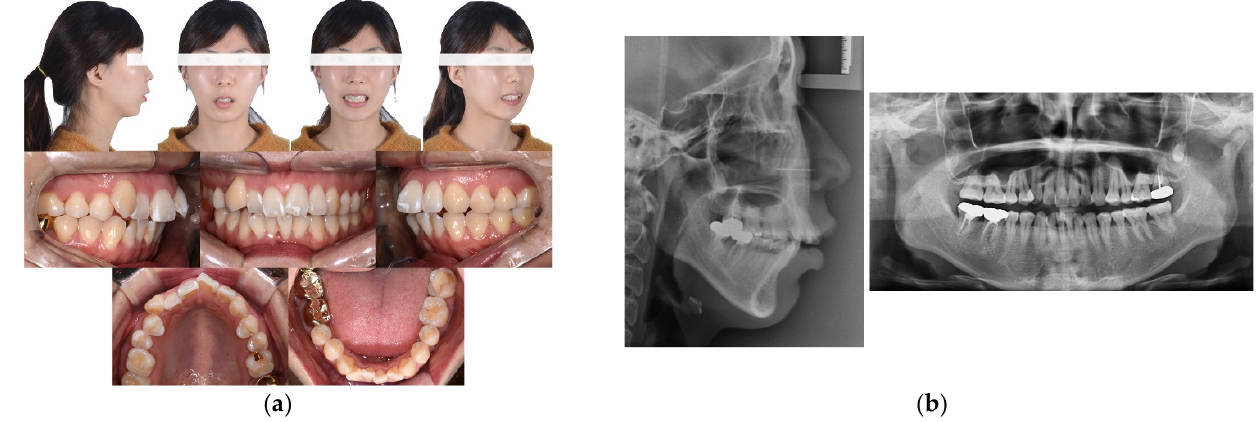
Figure 1. Pretreatment records: ( a ) facial and intraoral photographs, ( b ) lateral cephalogram, and panoramic